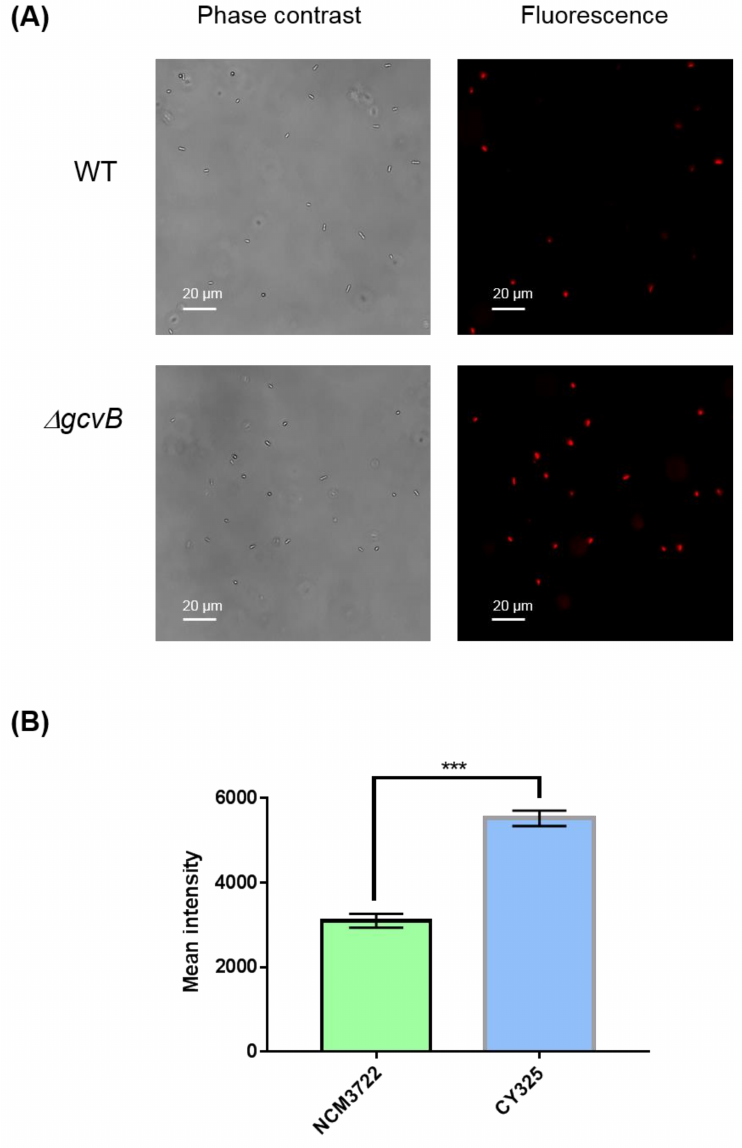
Figure 6. Detection of superoxide. ( A ) Detection of superoxide by DHE staining. The phase contrast shows the cells under microscope and the red fluorescence represents the detection of superoxide. Two to three independent observations were performed and one image containing representative cells is shown. ( B ) Quantification of fluorescence intensity. Fluorescence intensity was expressed as the average ± S.E.M., calculated from 393 to 416 individual cells. NCM3722 (WT); CY325 ( ∆ gcvB ). *** p < 0.001 using Student’s t